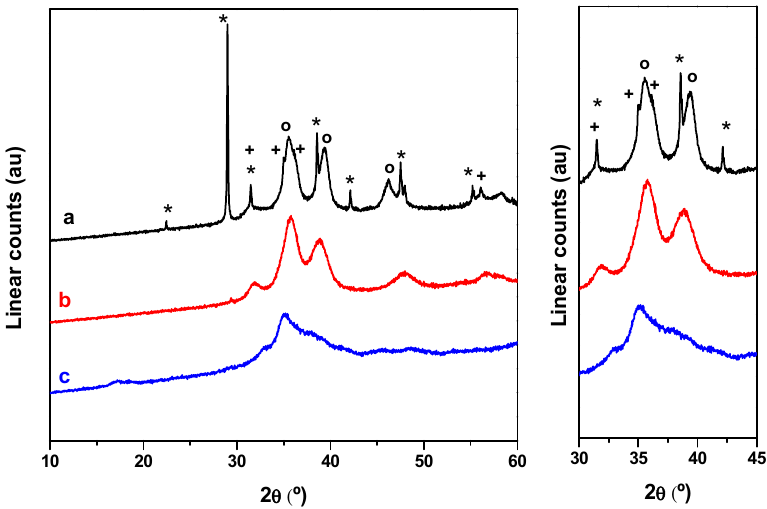
Figure 5. XRD profiles of calcined catalysts derived from hydroxycarbonate precursors: ( a ) CuO/ZnO-Al-W/O ( − ), ( b ) CuO/ZnO-Al-W1 ( − ), ( c ) CuO/ZnO-Al-W3 ( − ) (o CuO, + ZnO, * NaNO 3 ).